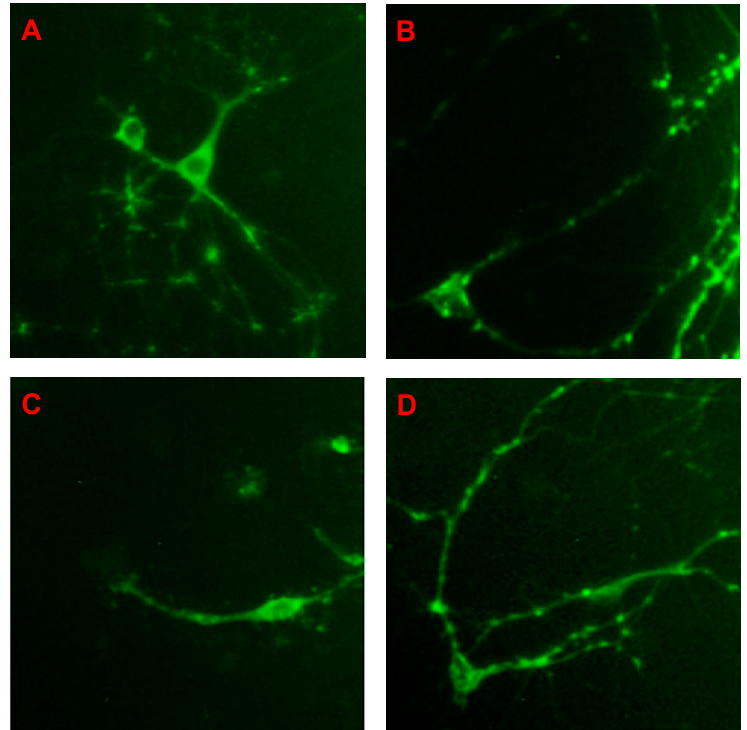
Figure 3. The effects of CGA ± Cort on the expression of synapsin I in the cells of fetal rat raphe neurons. ( A ) Control; ( B ) CGA treatment; ( C ) Cort treatment; and ( D ) Cort + CGA treatment. Notes: Fluorescence microscopy shows the representative images of neurons stained by FITC. The cells were treated with culture medium with 0.1% DMSO (control), or 1 nM CGA ± 10 µM Cort. The results are representative of at least three independent experiments.